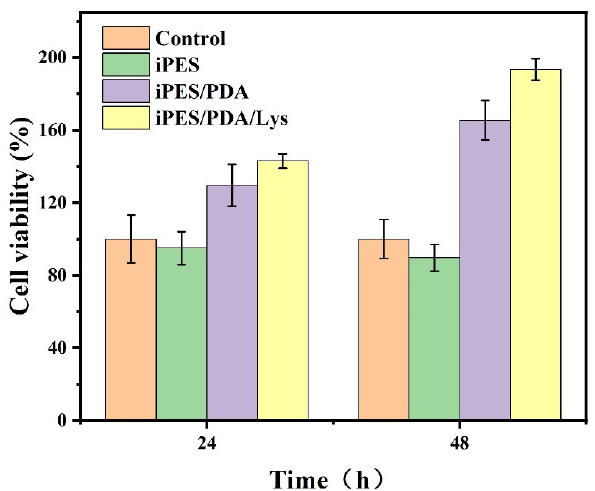
Figure 7. Cell viability of C3A after incubation with the membranes for 24 h and 48 h. Values are expressed as means ± SD (n = 4).